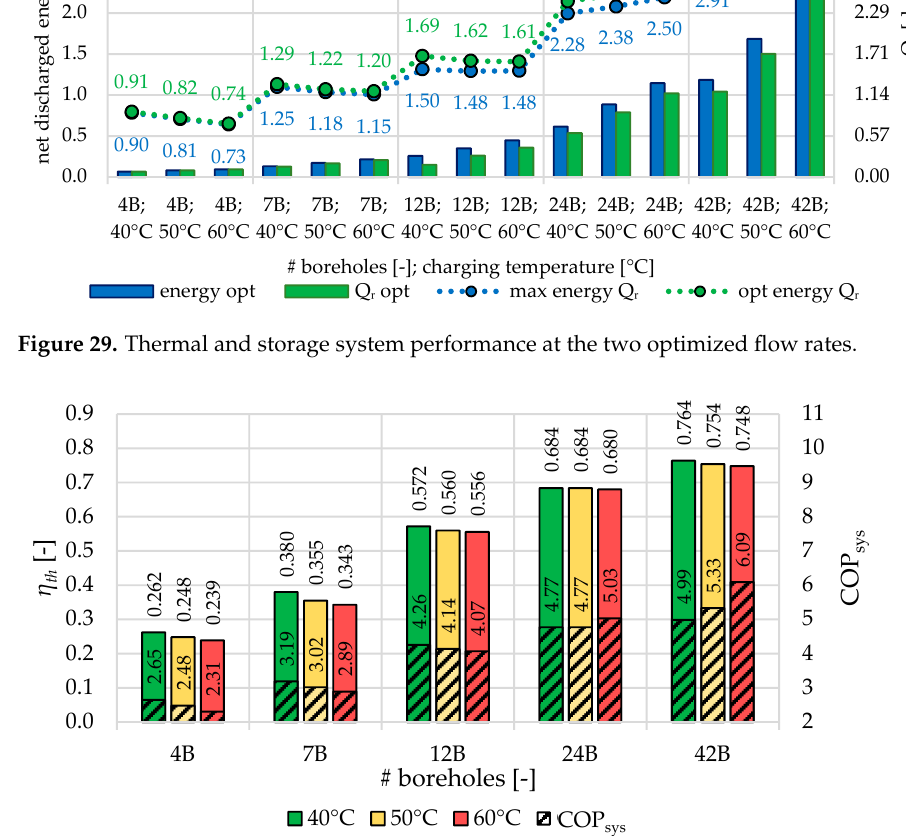
Figure 30. Thermal efficiency by charging temperature and configuration.